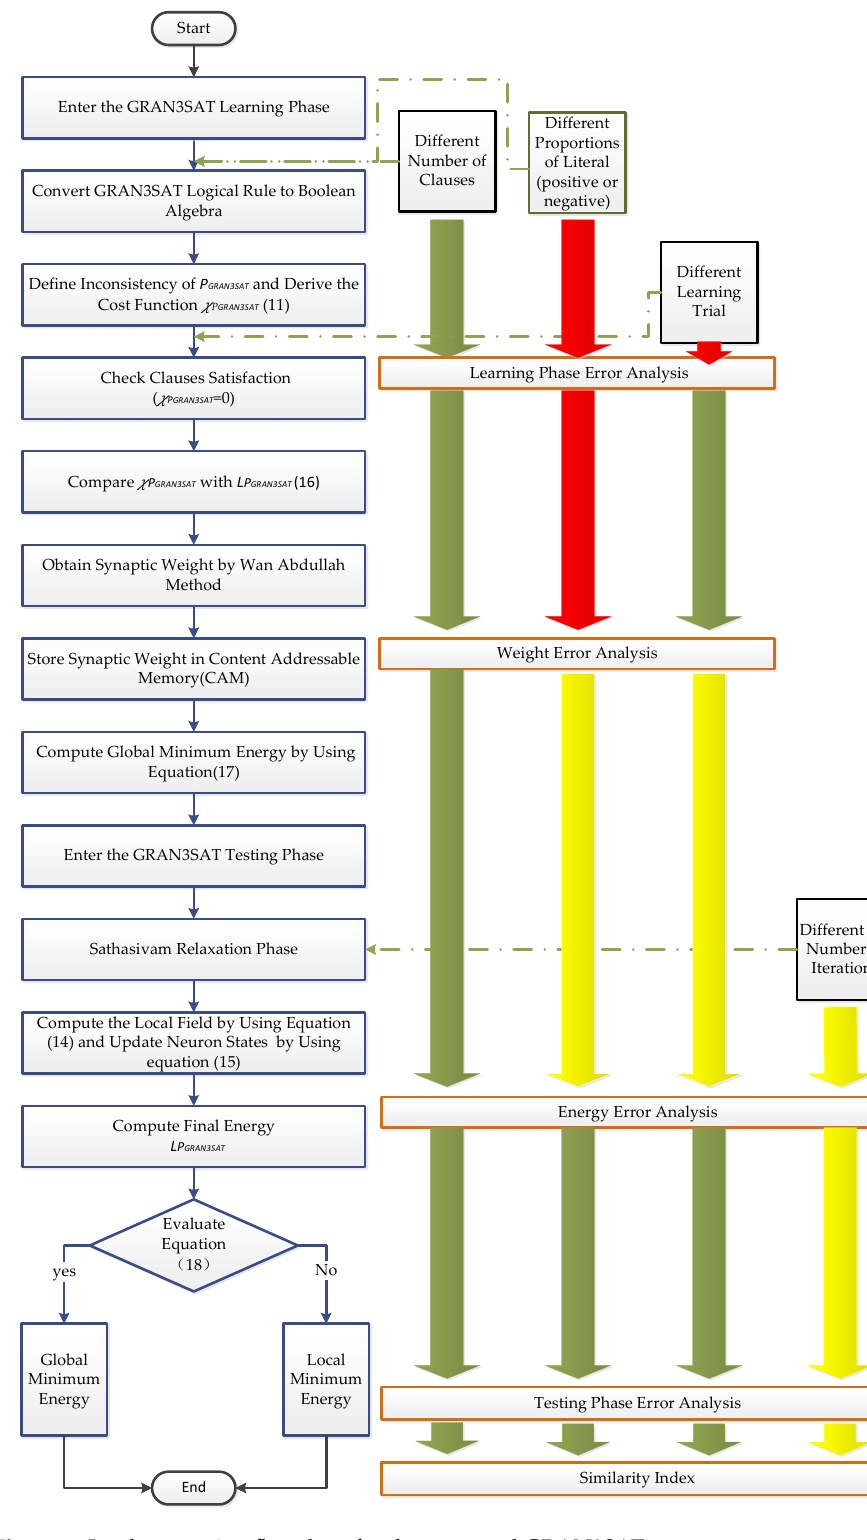
Figure 2. Implementation flowchart for the proposed GRAN3SAT.